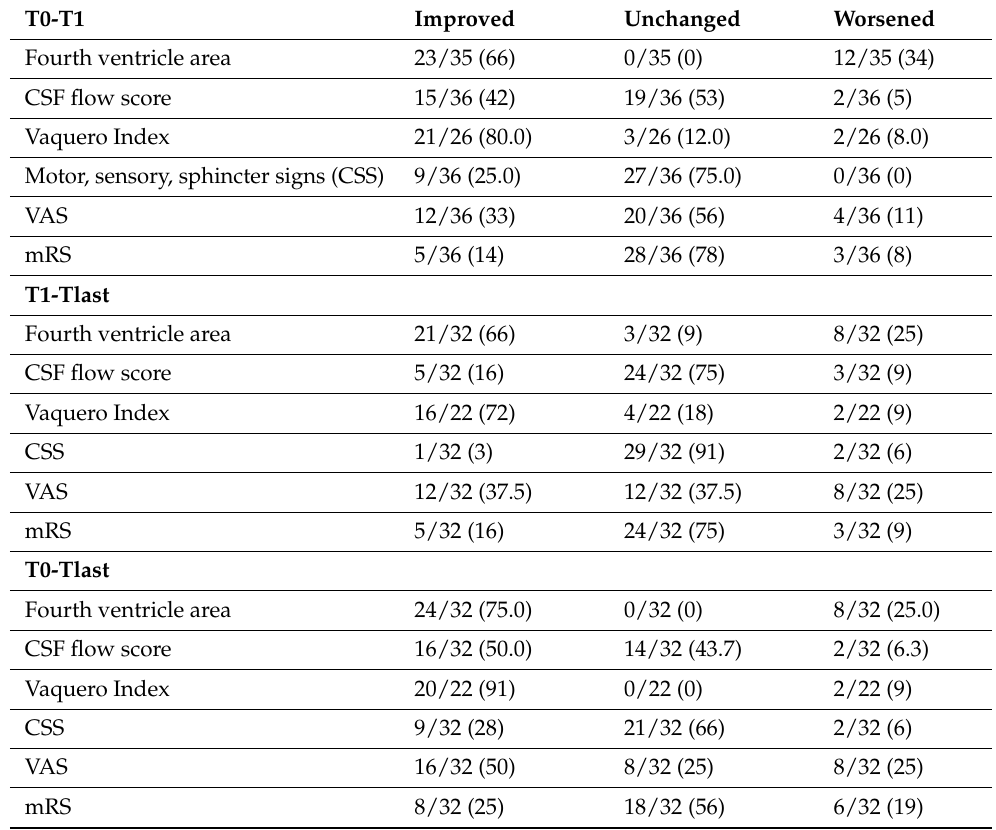
Table 3. Radiological and clinical variables: changes at T0-T1, T1-Tlast, T0-Tlast.